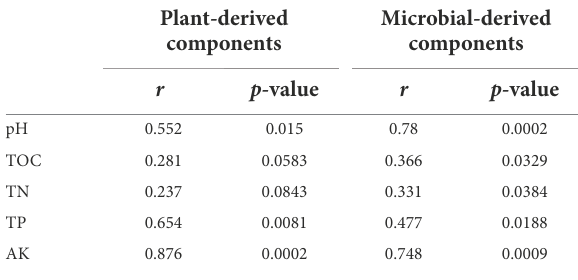
TABLE 1 Spearman’s correlation analysis and Mantel tests for microbial CAZyme families involved in the decomposition of the plant- and microbial-derived components against soil properties (9,999